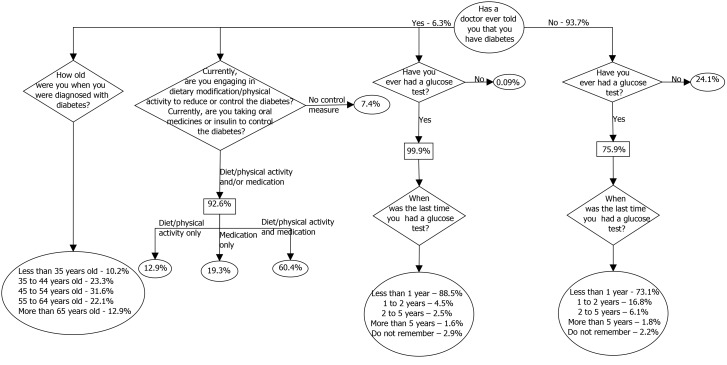
Flow diagram showing the characterization of self-reported diabetes cases.Description of the diabetes questionnaire from VIGITEL 2011: It is presented the answers according to special diabetes questionnaire applied in the 2011 version of VIGITEL. The flow starts by the circle with the basic question “Has a doctor ever told you that you have diabetes?” and must follow the results according each answer provided. The left side presents the results for those who reported having diabetes and the right side for those not reporting a previous diagnosis of diabetes. Percents weighted so as to represent the adult population of Brazilian capitals and the Federal District projected for the year 2011. VIGITEL: Vigilância de Fatores de Risco e Proteção para Doenças Crônicas por Inquérito Telefônico (in English, Surveillance System for Risk and Protective Factors for Chronic Diseases by Telephone Survey).